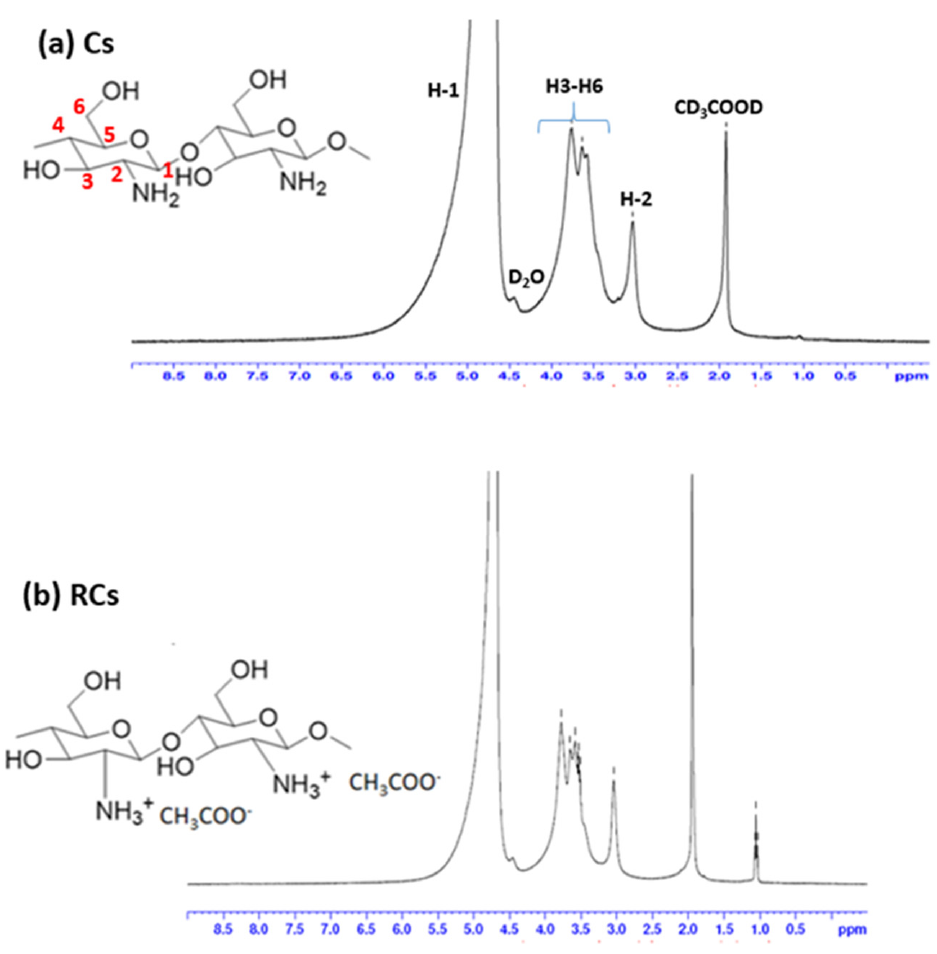
Figure 3. 1 H-NMR spectra of ( a ) Cs and ( b ) RCs.